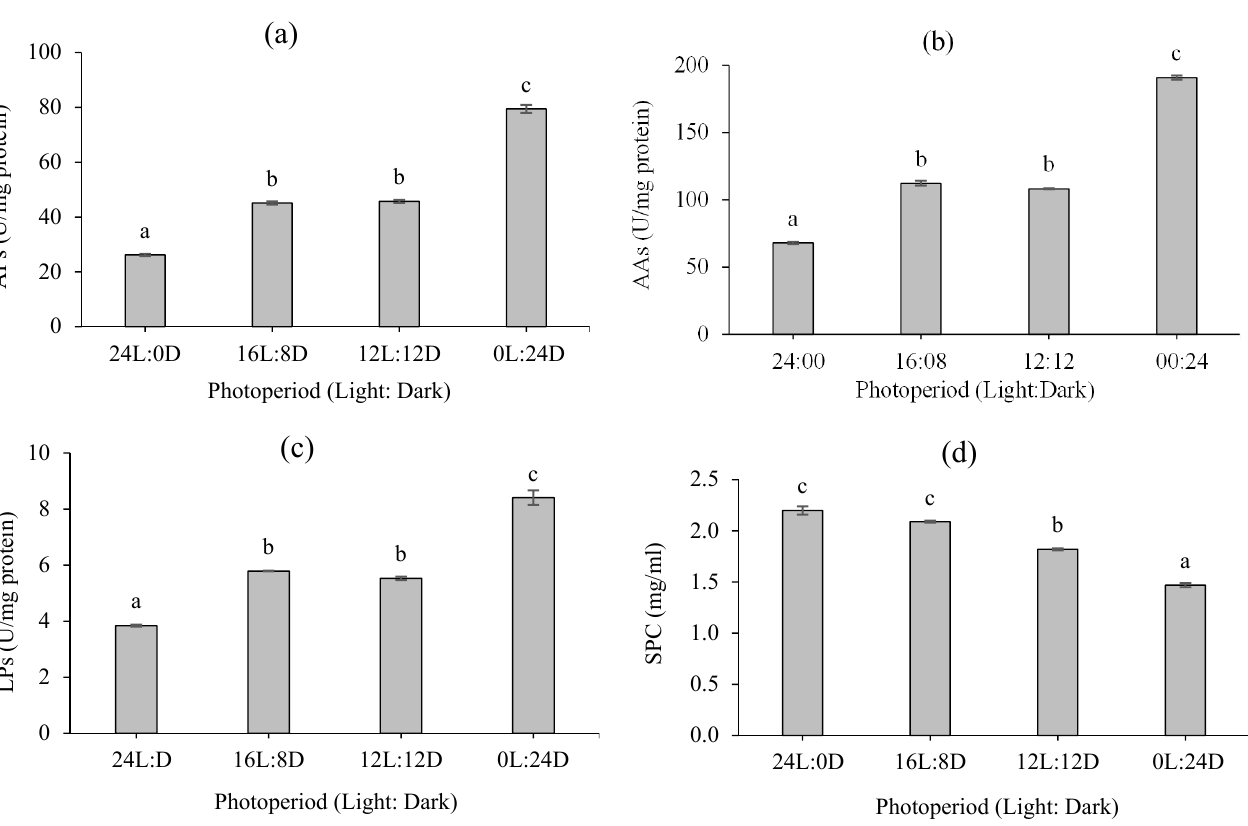
Figure 3. Effect of different photoperiods on digestive enzyme activity of B. orientalis at the end of the experimental period (mean ± SD, n = 3): ( a ) alkaline protease (AP), ( b ) alpha-amylase (AA), ( c ) lipase (LP), and ( d ) soluble protein content (SPC). Different superscript letters denote statistically significant differences at p < 0.05.